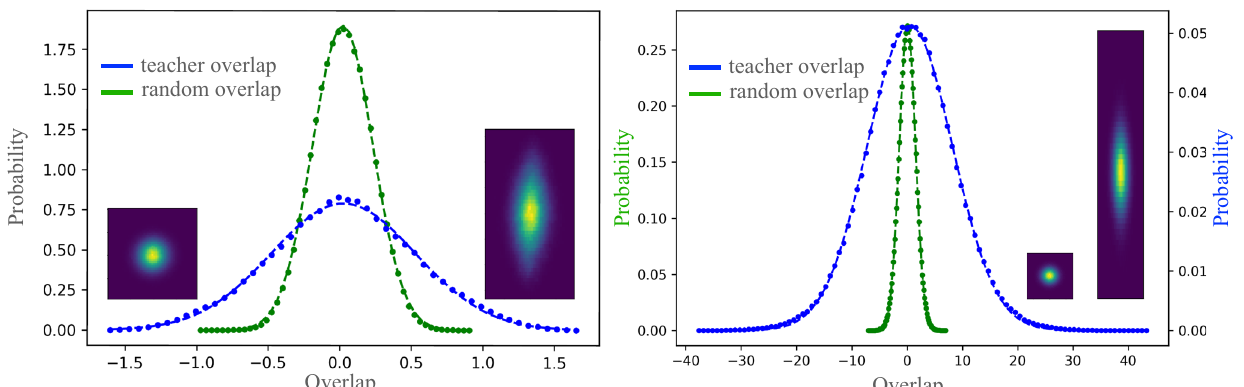
Fig. 4 | Pre-activation statistics in the 3-layer student-teacher setting. Left. Histogram of student input weight vector, dotted with the normalized teacher weight (blue) and normalized random weight (green). Right. Histogram of student hidden layer pre-activations, dotted with the normalized teacher pre-activations (blue) and normalized pre-activations of a random teacher (green). Dots are